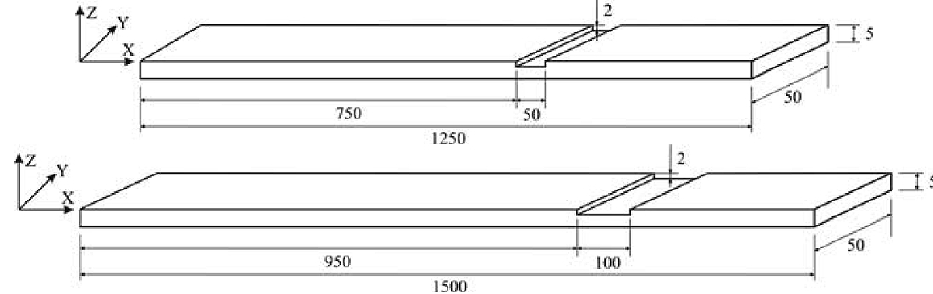
Fig. 1. Geometry and dimensions of the test beams containing mill-cut